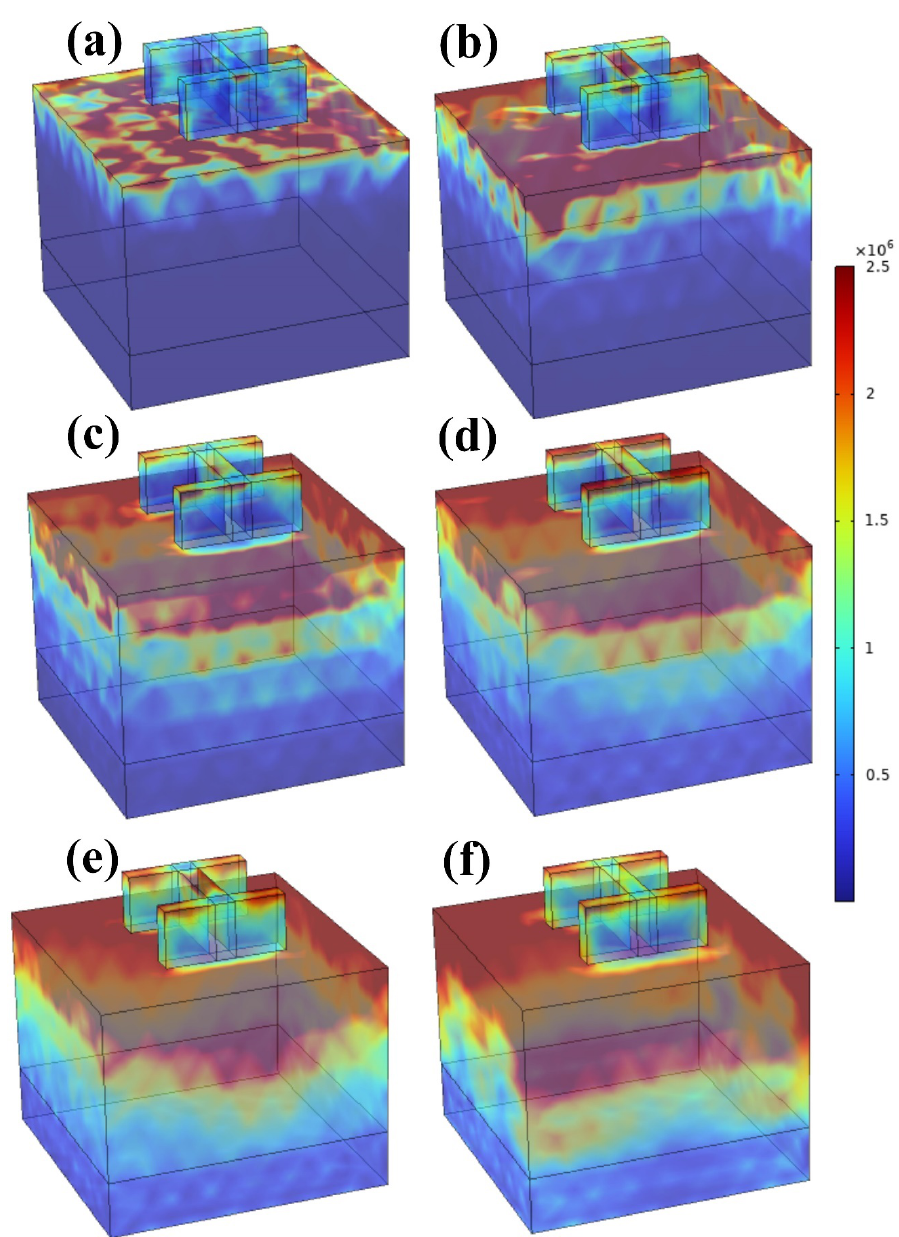
Figure 3. E-field results for the I-shaped metamaterial design backed by gallium arsenide at ( a ) 500 nm, ( b ) 1000 nm, ( c ) 1500 nm, ( d ) 2000 nm, ( e ) 2500 nm, and ( f ) 3000 nm. The color bar shows the electric field values, which are at their highest value of 2.5 × 10 6 V/m.